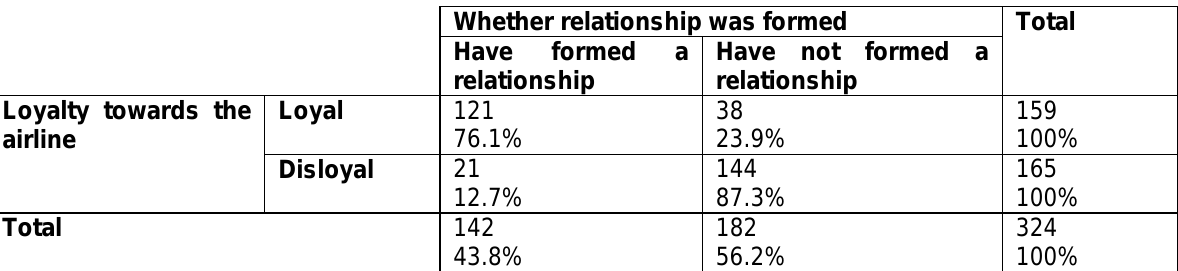
Have not formed a relationship 38 23.9% 144 87.3% 182 56.2%